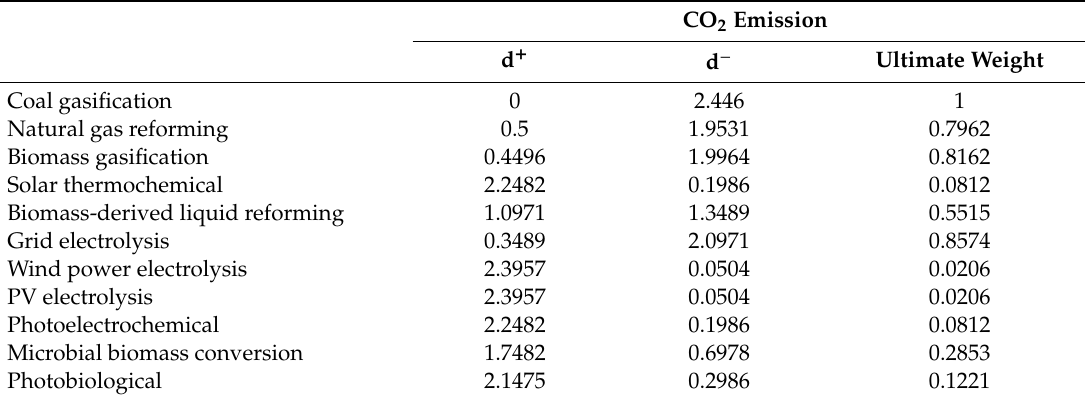
Table A2. Distance from FPIS and FNIS, and ultimate weights of CO 2 emission.